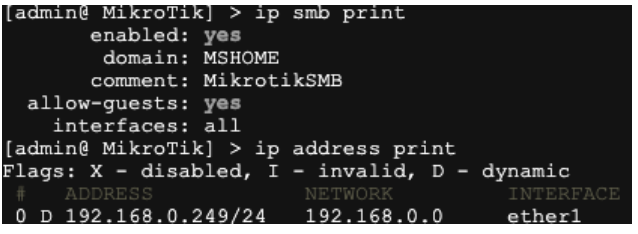
Figure 6. The successful exploitation of a remote Server Message Block (SMB) service of MikroTik RouterOS in Listing